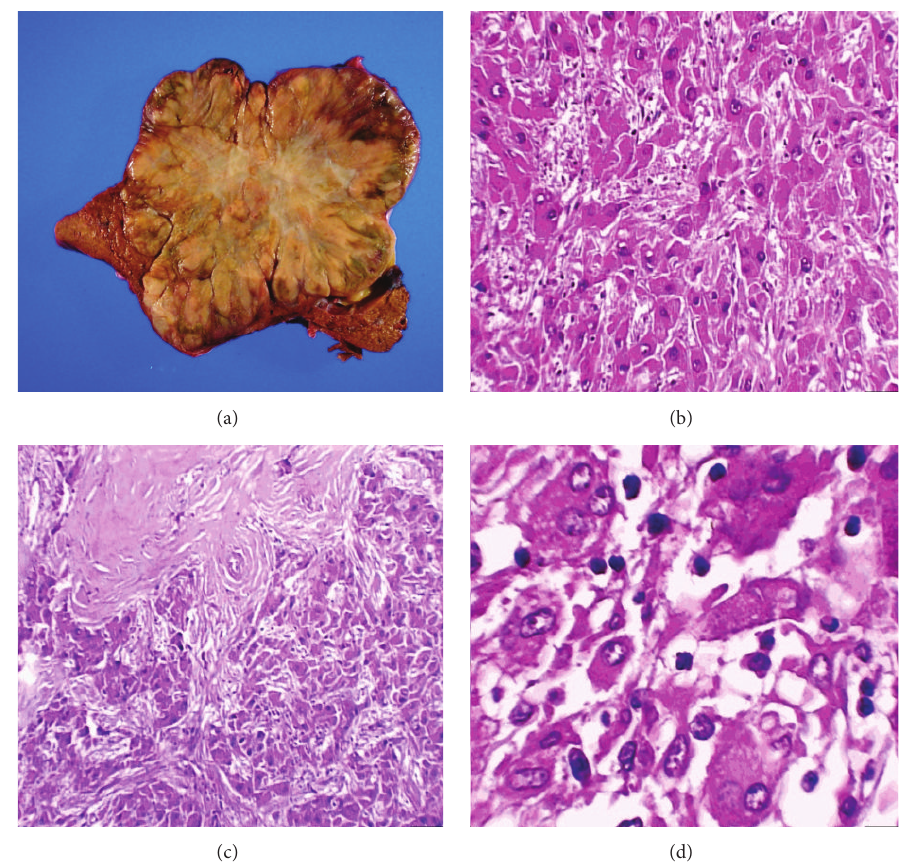
Figure 3: (a) Macroscopic image of the liver that shows a 9 × 7 cm, central yellowish lesion with diffuse, infiltrating borders with a whitish central lesion. (b) shows neoplastic cells separated into nodules by connective tissue (H and E stain, 50x). (c) Neoplastic cells with loss of the nucleus-cytoplasm relationship (H and E stain, 100x). (d) Image that shows the cellular and nuclear pleomorphism in greater detail (H and E stain,